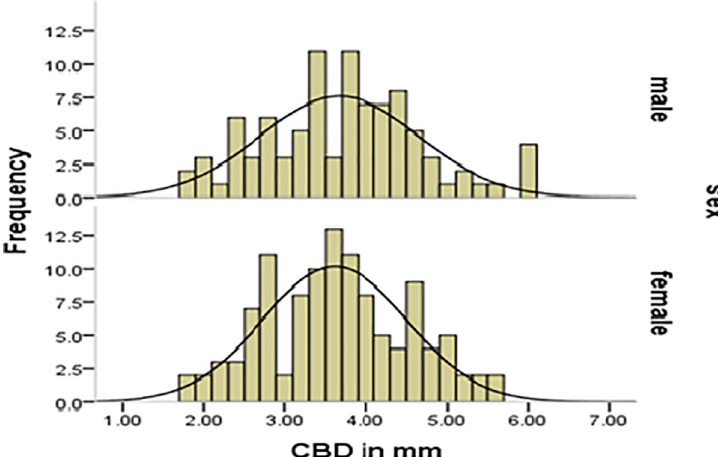
Fig 4. Histogram showing the frequency distribution of common bile duct diameter by